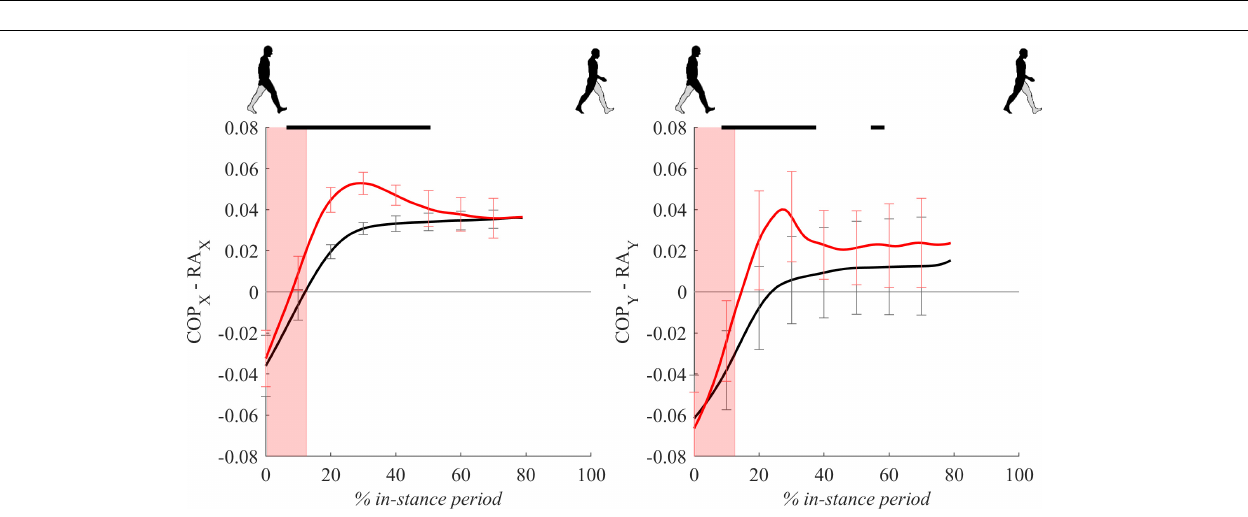
FIGURE 4 | Dimensionless group-average COM and GRF responses after outward perturbations ( N = 12, except for COMx where N = 11). Black corresponds with the unperturbed experimental condition, red with perturbed experimental conditions. Standard deviations are shown at each 10% of a gait cycle. One gait cycle divided into the in-stance and stepping periods, normalized to its duration separately for each experimental condition, is shown following a perturbing push. To visualize normalization of both periods short discontinuity is introduced on abscise. The perturbation period is marked with the red bar. Periods where statistically significant changes were determined between both experimental conditions are indicated with piece-wise continuous black lines on top of each graph.